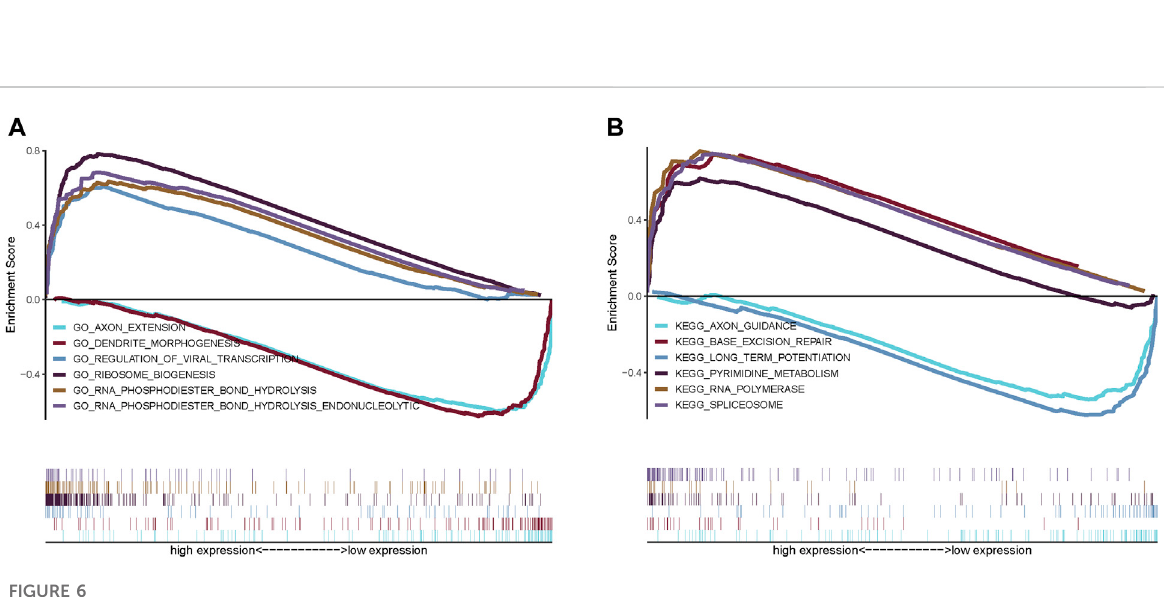
FIGURE 6 GSEA analysis of risk scores. (A) GO pathways; (B) KEGG